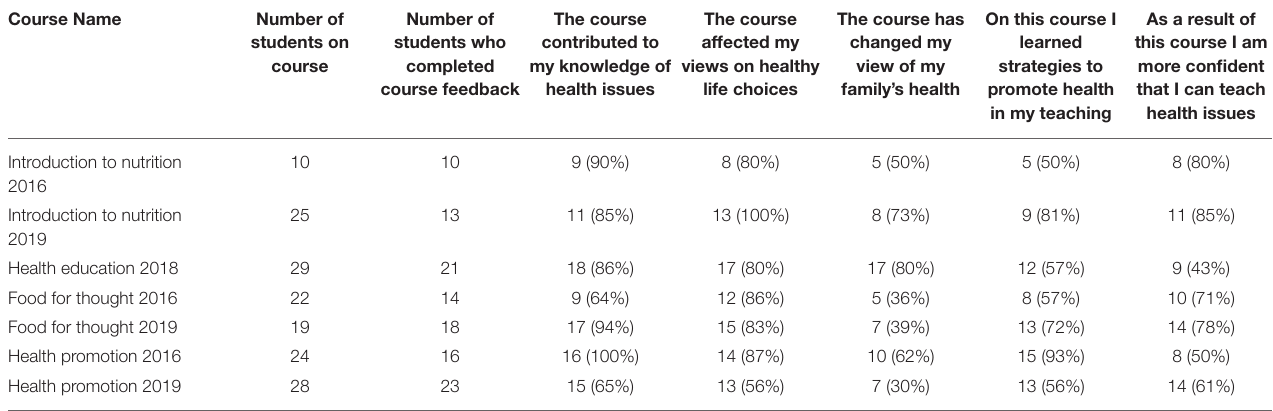
TABLE 5 | Feedback from teachers in training on Oranim health promotion courses.